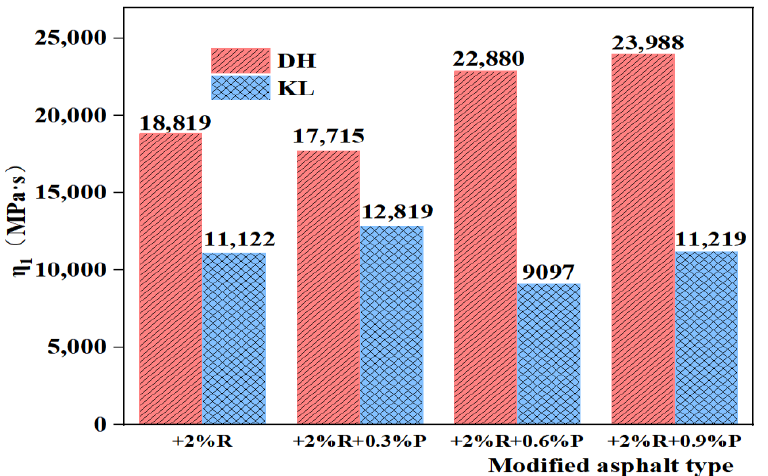
Figure 13. The η 1 value of composite modified asphalt with different PPA/SBR dosages.